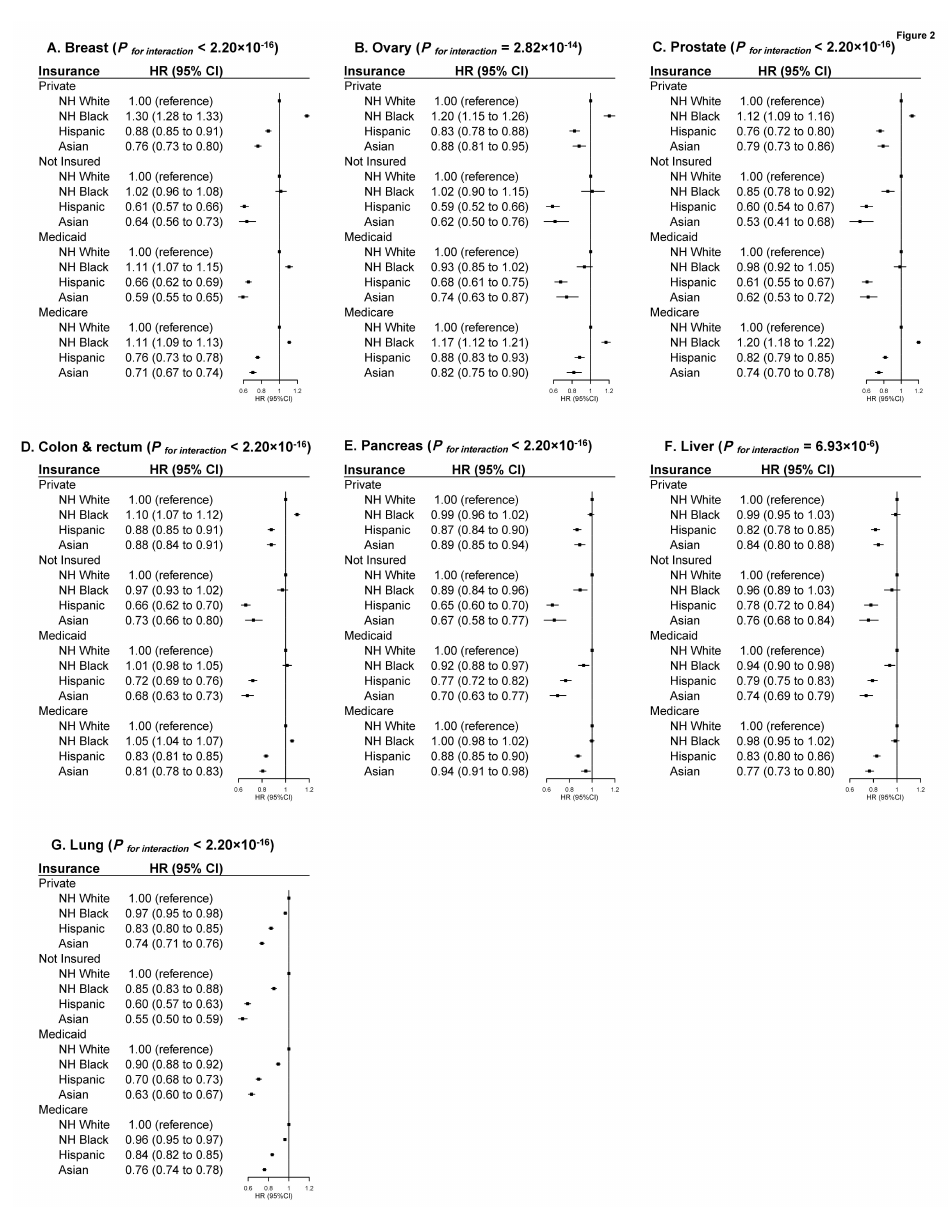
Figure 2. Multivariable-adjusted HRs and 95% CIs for Total Mortality Associated with Race/ethnicity According to Insurance Status in Major Cancer Types. The HRs and 95% CIs for total mortality associated with race/ethnicity according to insurance status in major cancer types (( A ) Breast Cancer; ( B ) Ovarian Cancer; ( C ) Prostate Cancer; ( D ) Colorectal Cancer; ( E ) Pancreatic Cancer; ( F ) Liver Cancer; ( G ) Lung Cancer). The HRs and 95% CIs were adjusted for age, sex (if applicable), biology (histology type, grade, TNM stage, LVI, comorbidity; ER, PR, HER2 for breast cancer; CA 125 for ovarian cancer; PSA and Gleason grade for prostate cancer; CA 19-9 for pancreatic cancer; AFP, Fibrosis Score, INR for liver cancer; separate tumor nodules for lung cancer; primary site, CEA, circumferential resection margin for colorectal cancer), treatment factors (surgery, chemotherapy, interval between diagnosis to first treatment; and endocrine therapy, radiation, immunotherapy, if applicable) and access to care (education, income, facility type, region, urban/rural residence, distance to care, and year of diagnosis). p values for interaction between racial/ethnic groups and insurance groups were derived from log likelihood test. Cancer patients with unspecified government insurance or unknown insurance status were not included in this analysis. Abbreviation: HR, Hazard Ratio; CI, Confidence